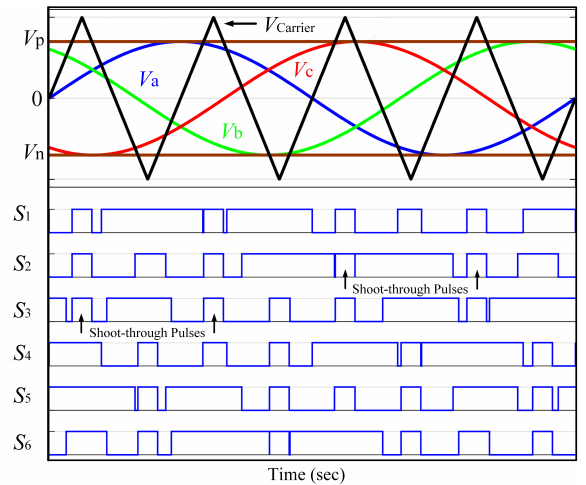
Figure 6. Switching signals of simple boost pulse width modulation (PWM)